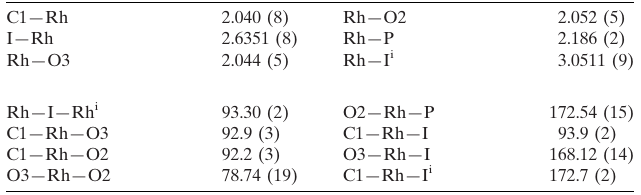
Selected geometric parameters (A˚ , (cid:3)